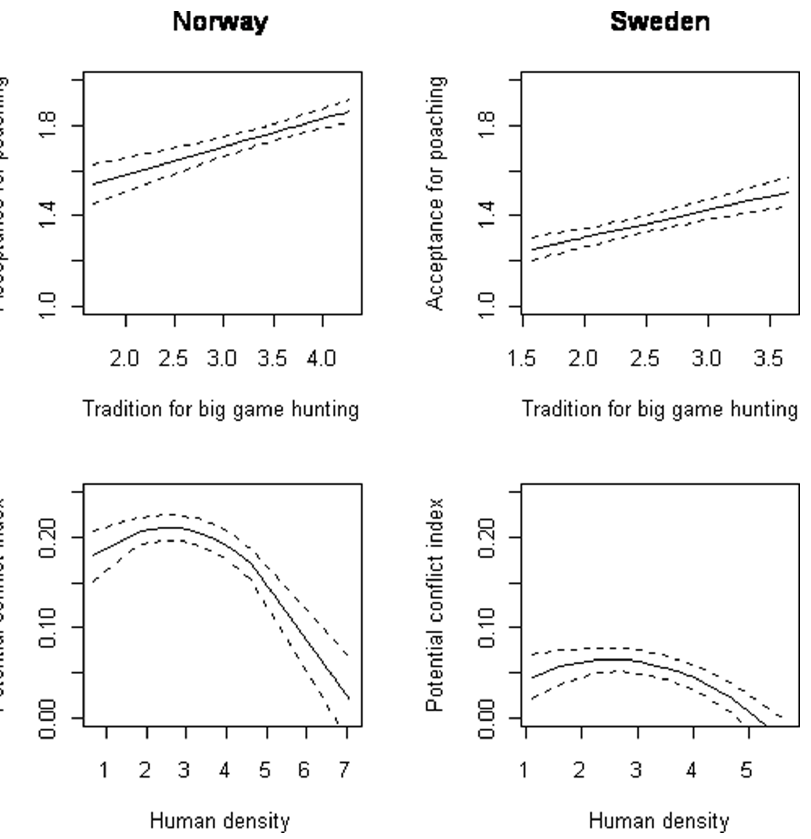
Figure 2. The correlation between acceptance for poaching and traditions for big game hunting (upper panel), and between the potential conflict index (PCI 2 ) and human density (log transformed; lower panel) at county level.